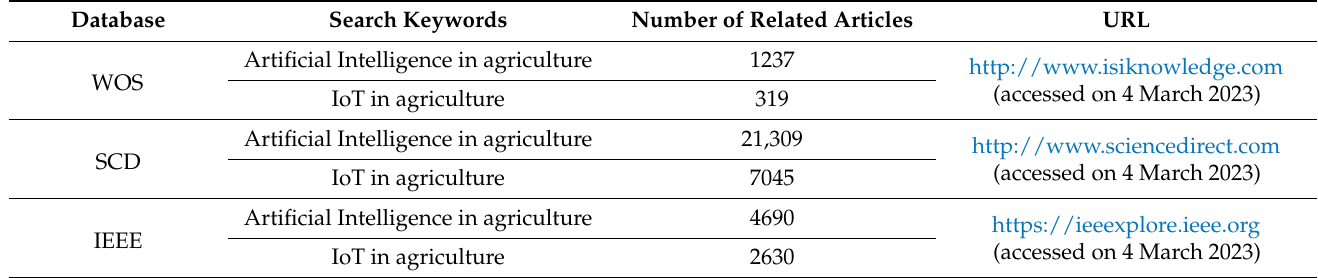
Table 6. Number of articles reported for AI and IoT in smart